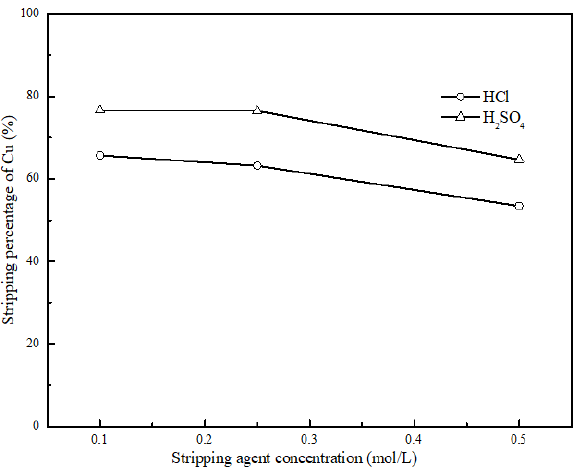
Figure 11. Stripping of Cu from Cu-loaded TOPO with various concentrations of